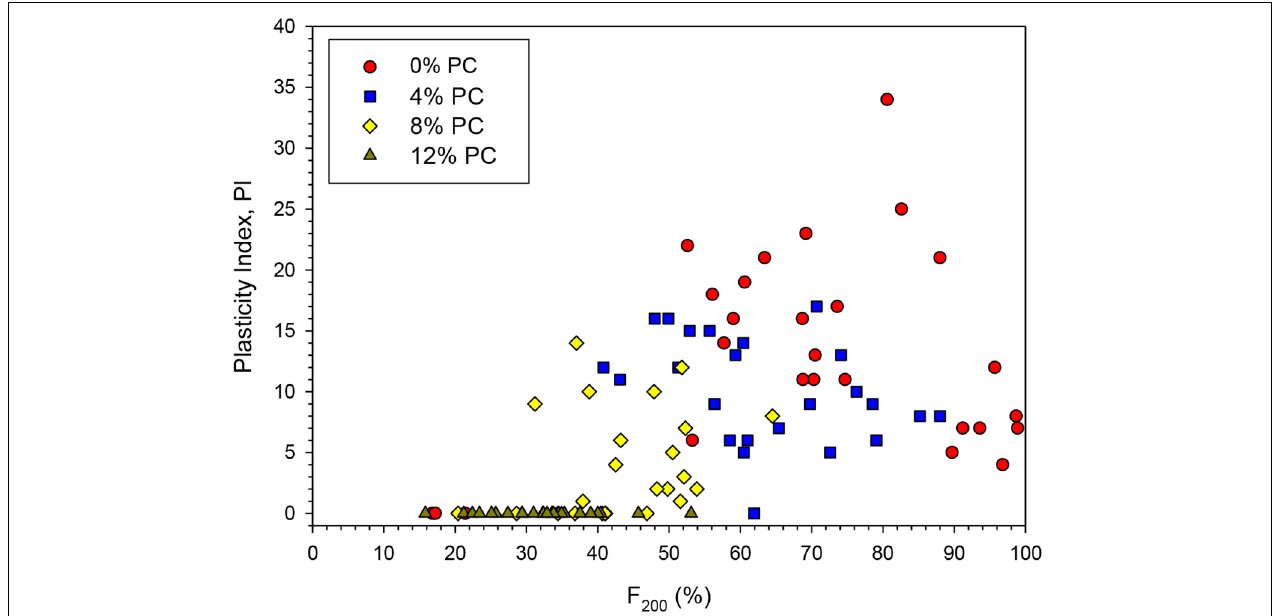
FIGURE 4 | PI versus F 200 for the untreated and cement treated